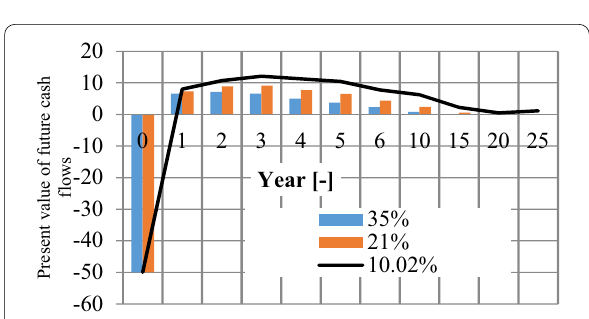
Fig. 9 Net present values (million) of series of cash flows for different weighted costs of